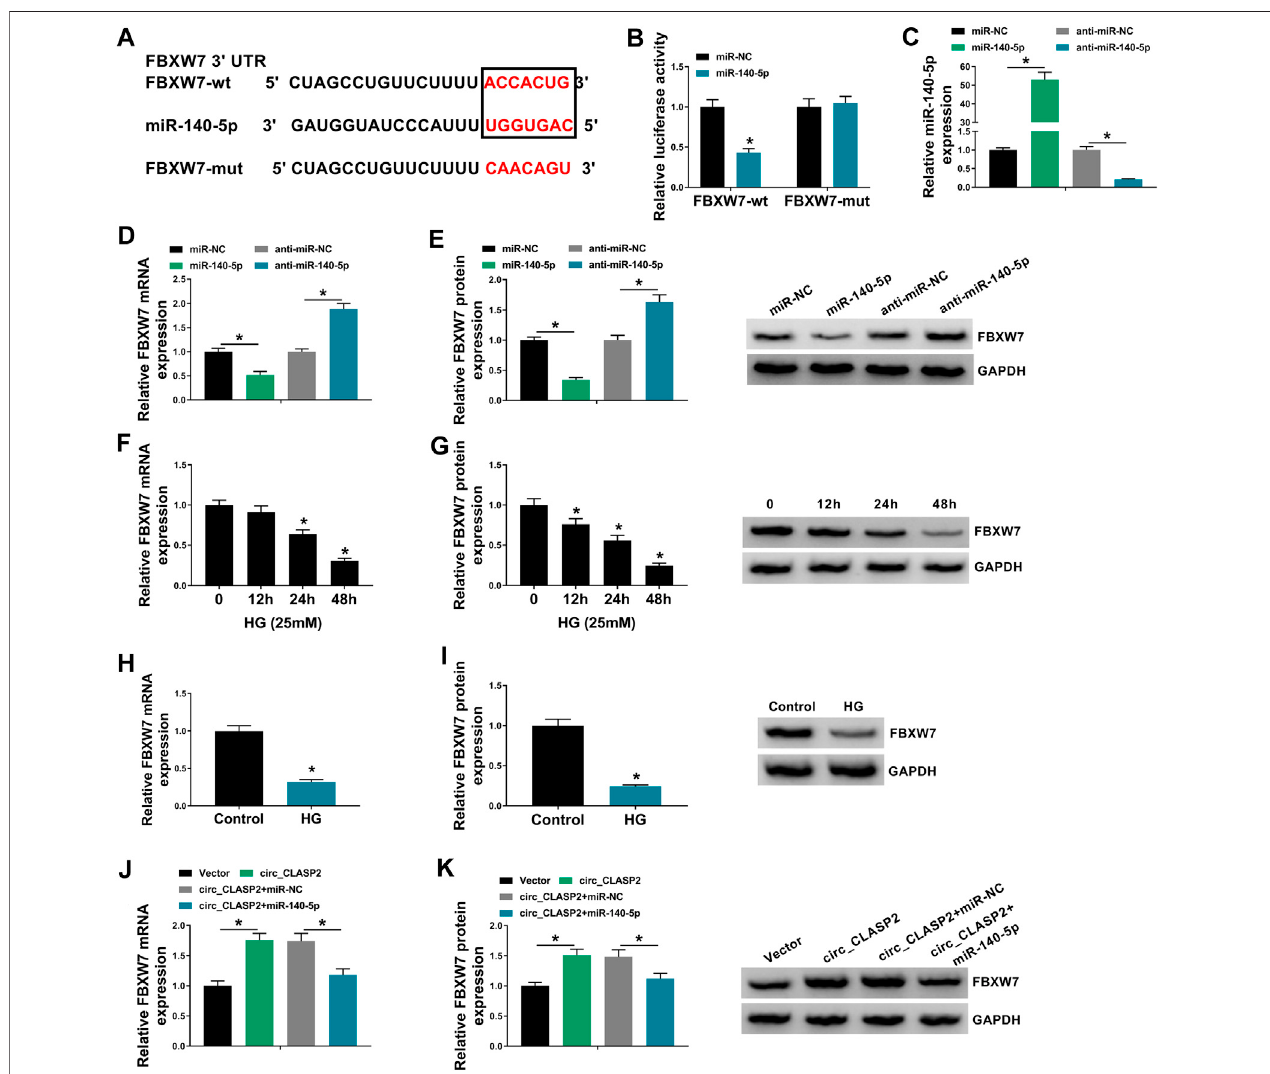
FIGURE 5 | Circ_CLASP2 mediated FBXW7 expression through sponging miR-140-5p. (A) Schematic of illuminating the target sequence for miR-140-5p within FBXW73 ′ -UTRandthemutantinthetargetregion. (B) RelativeluciferaseactivitywasdetectedinHUVECstransfectedwithFBXW73 ′ -UTRluciferasereporter(FBXW7- wt) or the mutant in the miR-140-5p – binding sites (FBXW7-mut) and miR-140-5p mimic or miR-NC mimic. MiR-140-5p expression (C) , FBXW7 mRNA level (D) , and FBXW7proteinexpression (E) wereassessedbyqRT-PCRorWesternblotassayinHUVECstransfectedwithmiR-NCmimic,miR-140-5pmimic,anti-miR-NC,or anti-miR-140-5p. (F – I) FBXW7 mRNA and protein levels were detected in HUVECs after HG treatment. (J,K) FBXW7 mRNA and protein levels were tested in HUVECs transfectedwithVector,circ_CLASP2,circ_CLASP2+miR-NCmimic,orcirc_CLASP2+miR-140-5pmimic.Vector:negativecontrolvector,circ_CLASP2:circ_CLASP2 overexpression vector. n (cid:2) 3 independent biological replicates; data were presented as mean ± SD; * p < 0.05 by a two-tailed Student ’ s t -test or ANOVA followed by Tukey – Kramer post hoc test.